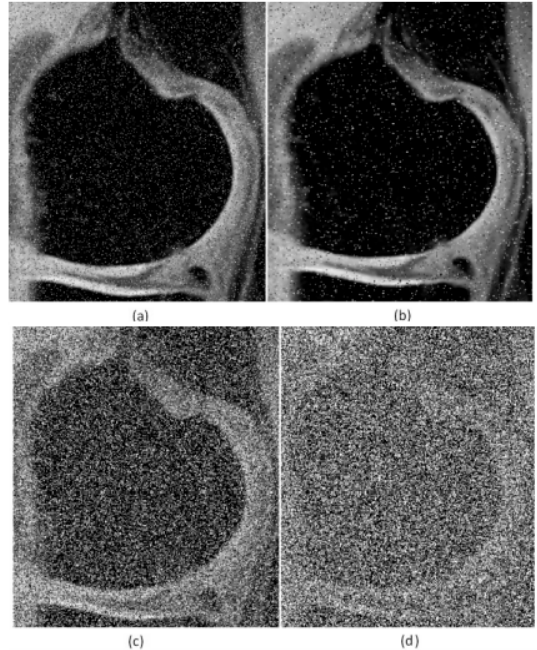
Figure 2. Selected area of interest (RoI) for MR image of articular cartilage with dynamic Salt and Pepper noise intensity (d): ( a ) d = 0.08, ( b ) d = 0.12, ( c ) d = 0.5, and ( d ) d = 0.85.